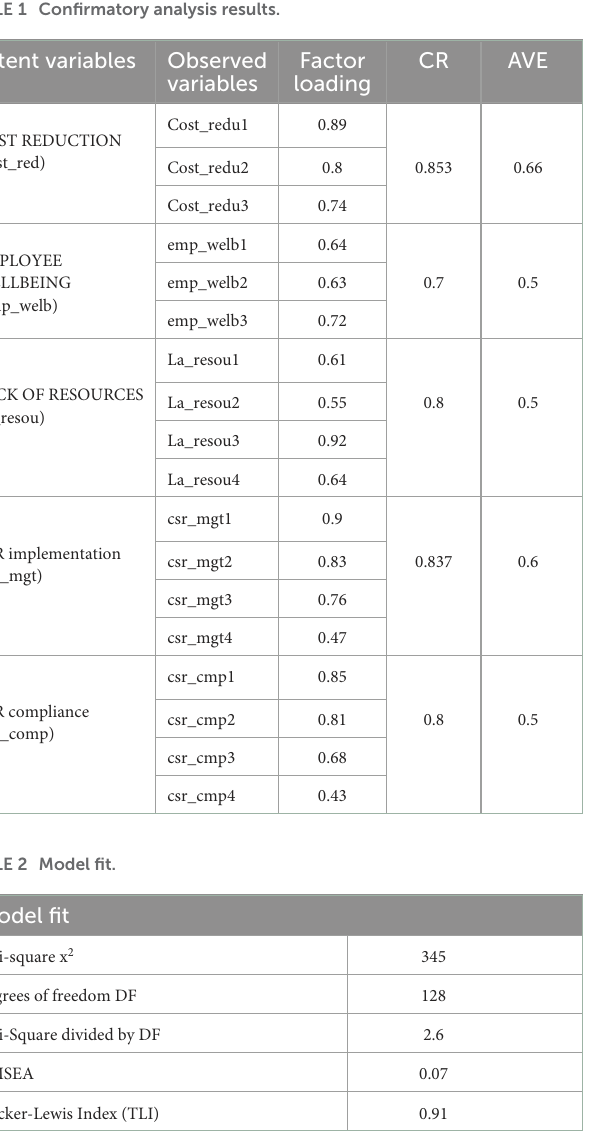
TABLE 1 Confirmatory analysis results.